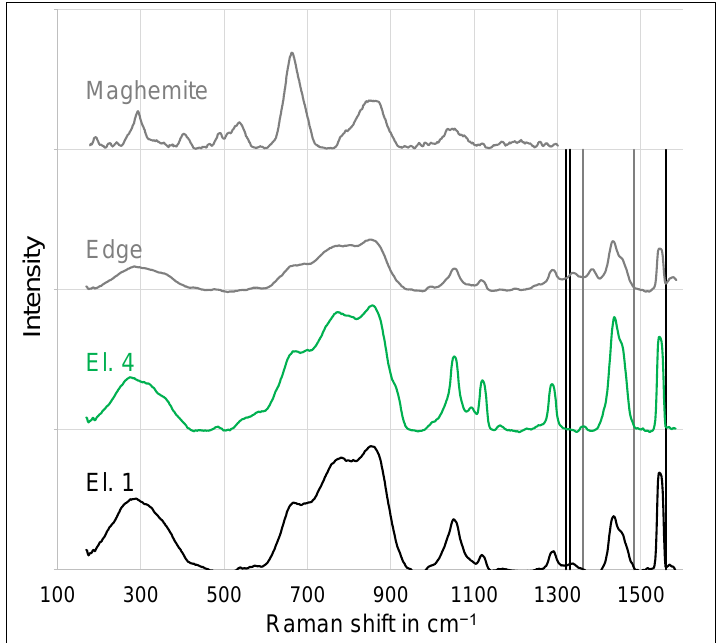
Figure 11. Raman spectra of layers produced in electrolytes 1 and 4 at OCP + 500 mV and reference spectra of the untreated sample edge and maghemite from [31], the vertical lines mark characteristic bands (black) and a broad peak (gray) of maghemite according to the literature [35–37].